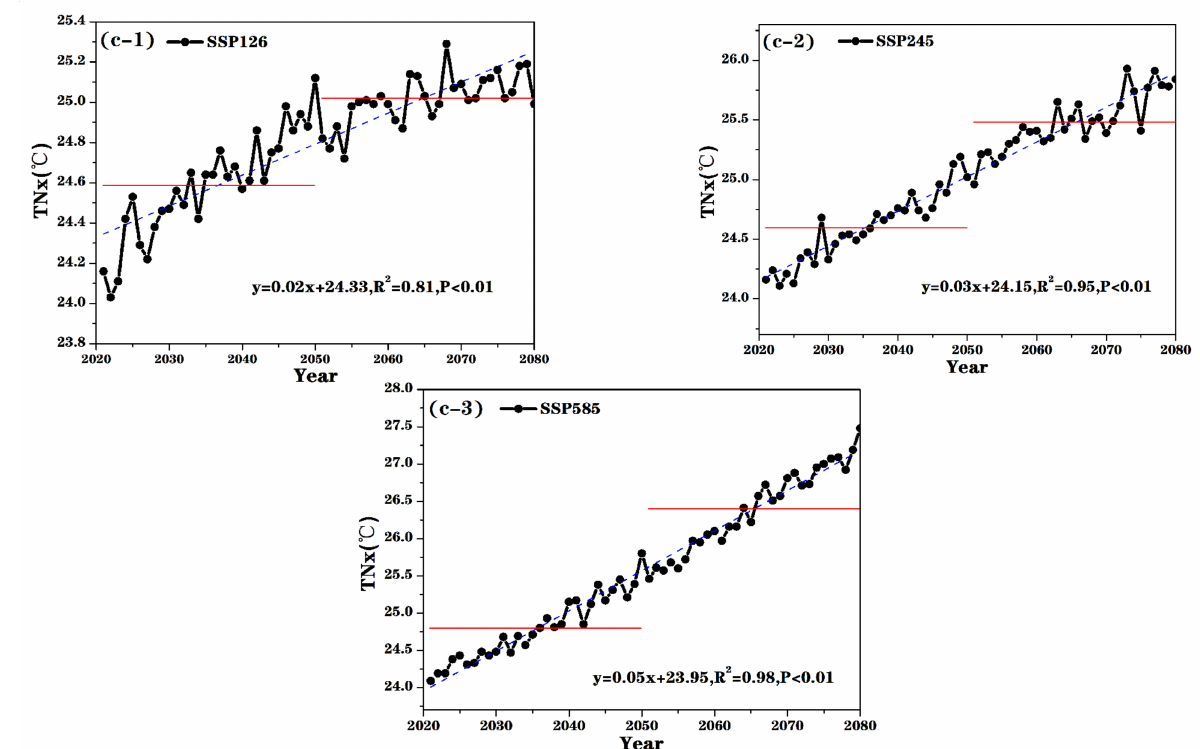
Figure 11. Temporal trends of extreme climate indices during 2021–2080 on the Mongolian Plateau for different SSP scenarios.(( a1 – a3 ): Temporal trends of R20 (Number of moderate precipitation days) in the SSP126/SSP245/SSP585 scenario, ( b1 – b3 ): Temporal trends of SU25 (Hot summer days) in the SSP126/SSP245/SSP585 scenario, ( c1 – c3 ): Temporal trends of TNx (An extremely high daily minimum temperature) in the SSP126/SSP245/SSP585